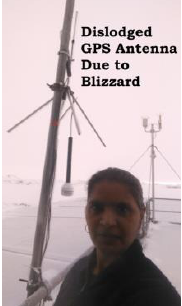
Figure 3. Dislodged GPS